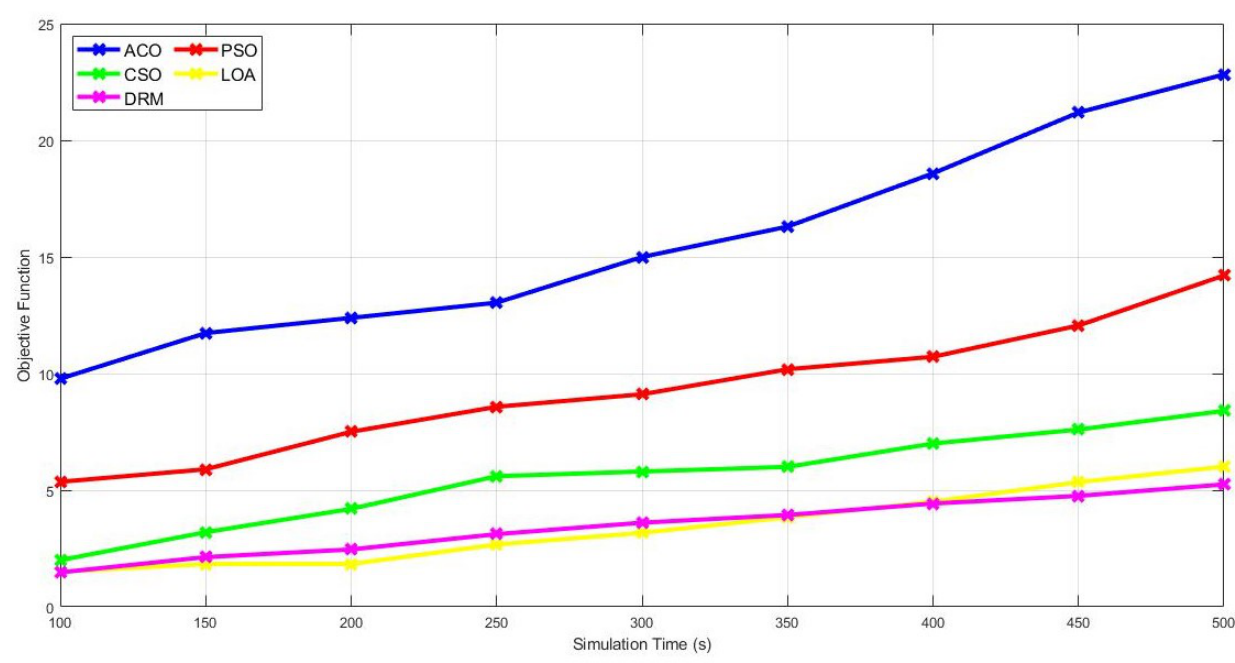
Figure 9. Objective function